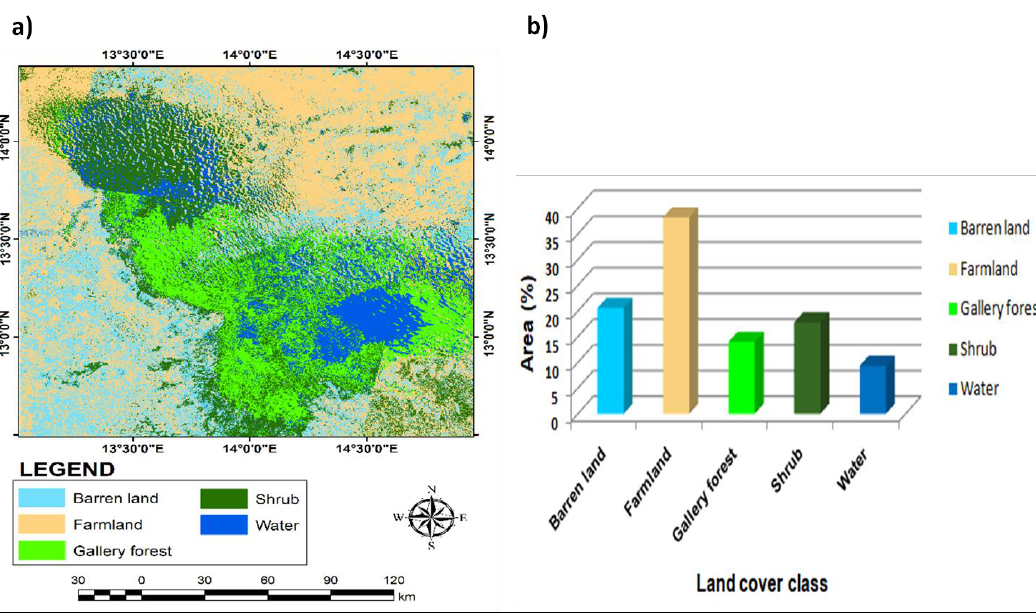
Figure 4. (a) Lake Chad change map in 2000, (b) area coverage percentage for each